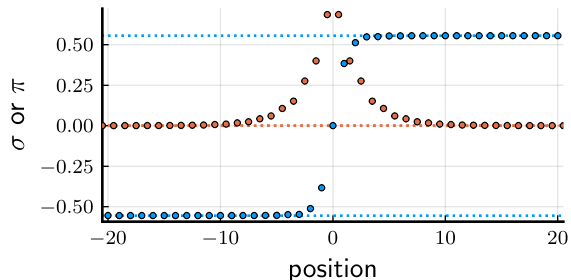
Figure 10 . A site-dependent solution of the large- N self-consistency equations with antiperiodic boundary conditions for σ (blue), the orange points indicate the π order parameter. The couplings are g 2 = 6 . 0 and g 2 = 2 . 3 ie. in bond ordered phase but close to the transition. Note that the x y expectation value of π becomes nonzero near the domain wall in σ